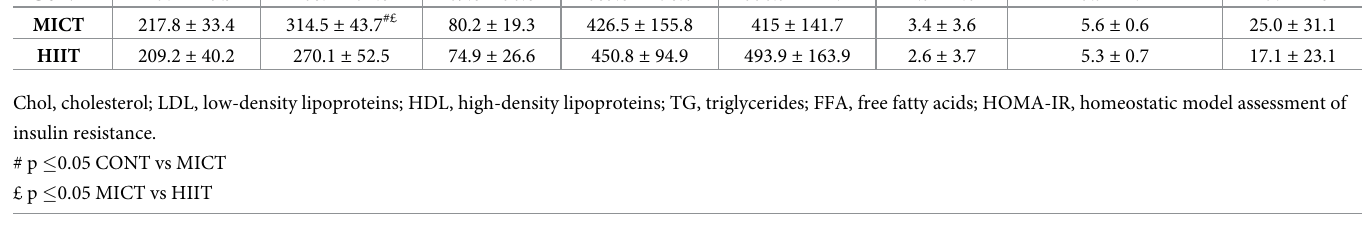
Table 1. Lipid and glycaemic profiles after 10 weeks of training (mean ± SD). Total Chol (mg.dL -1